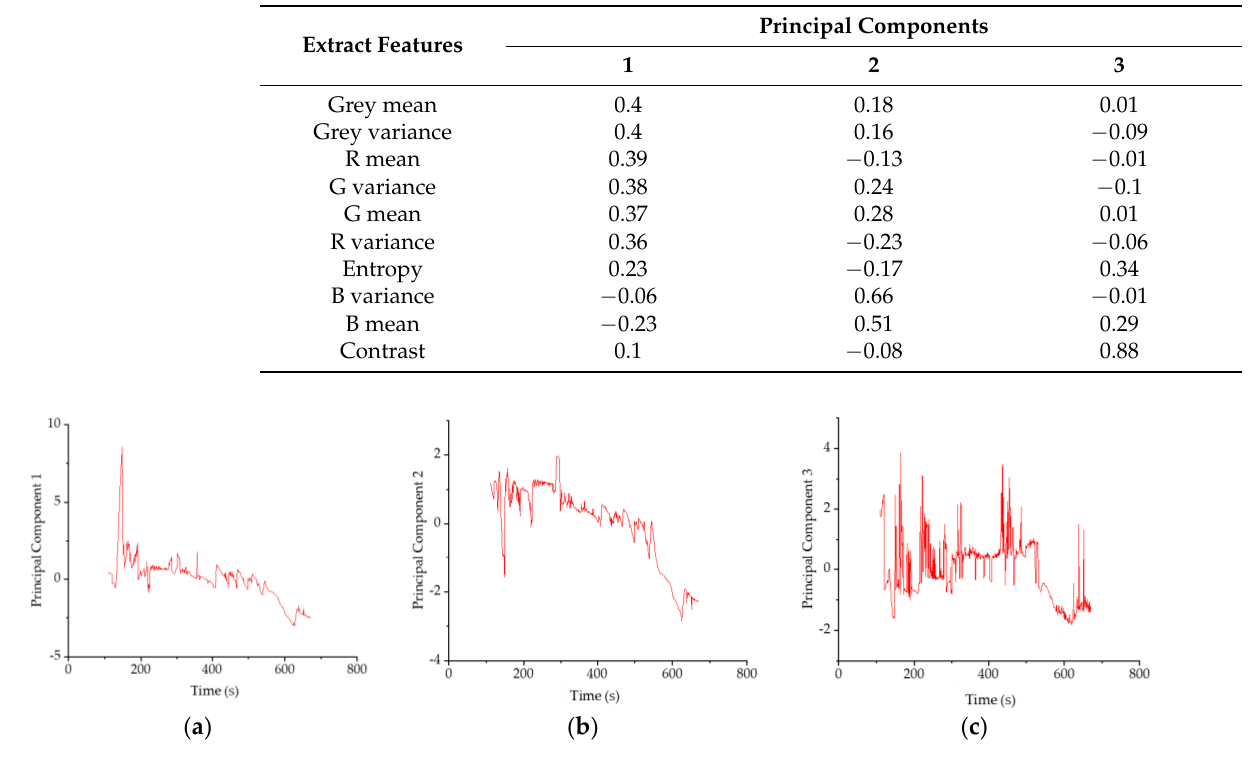
Table 3. Principal component loads of principal components 1, 2, and 3.